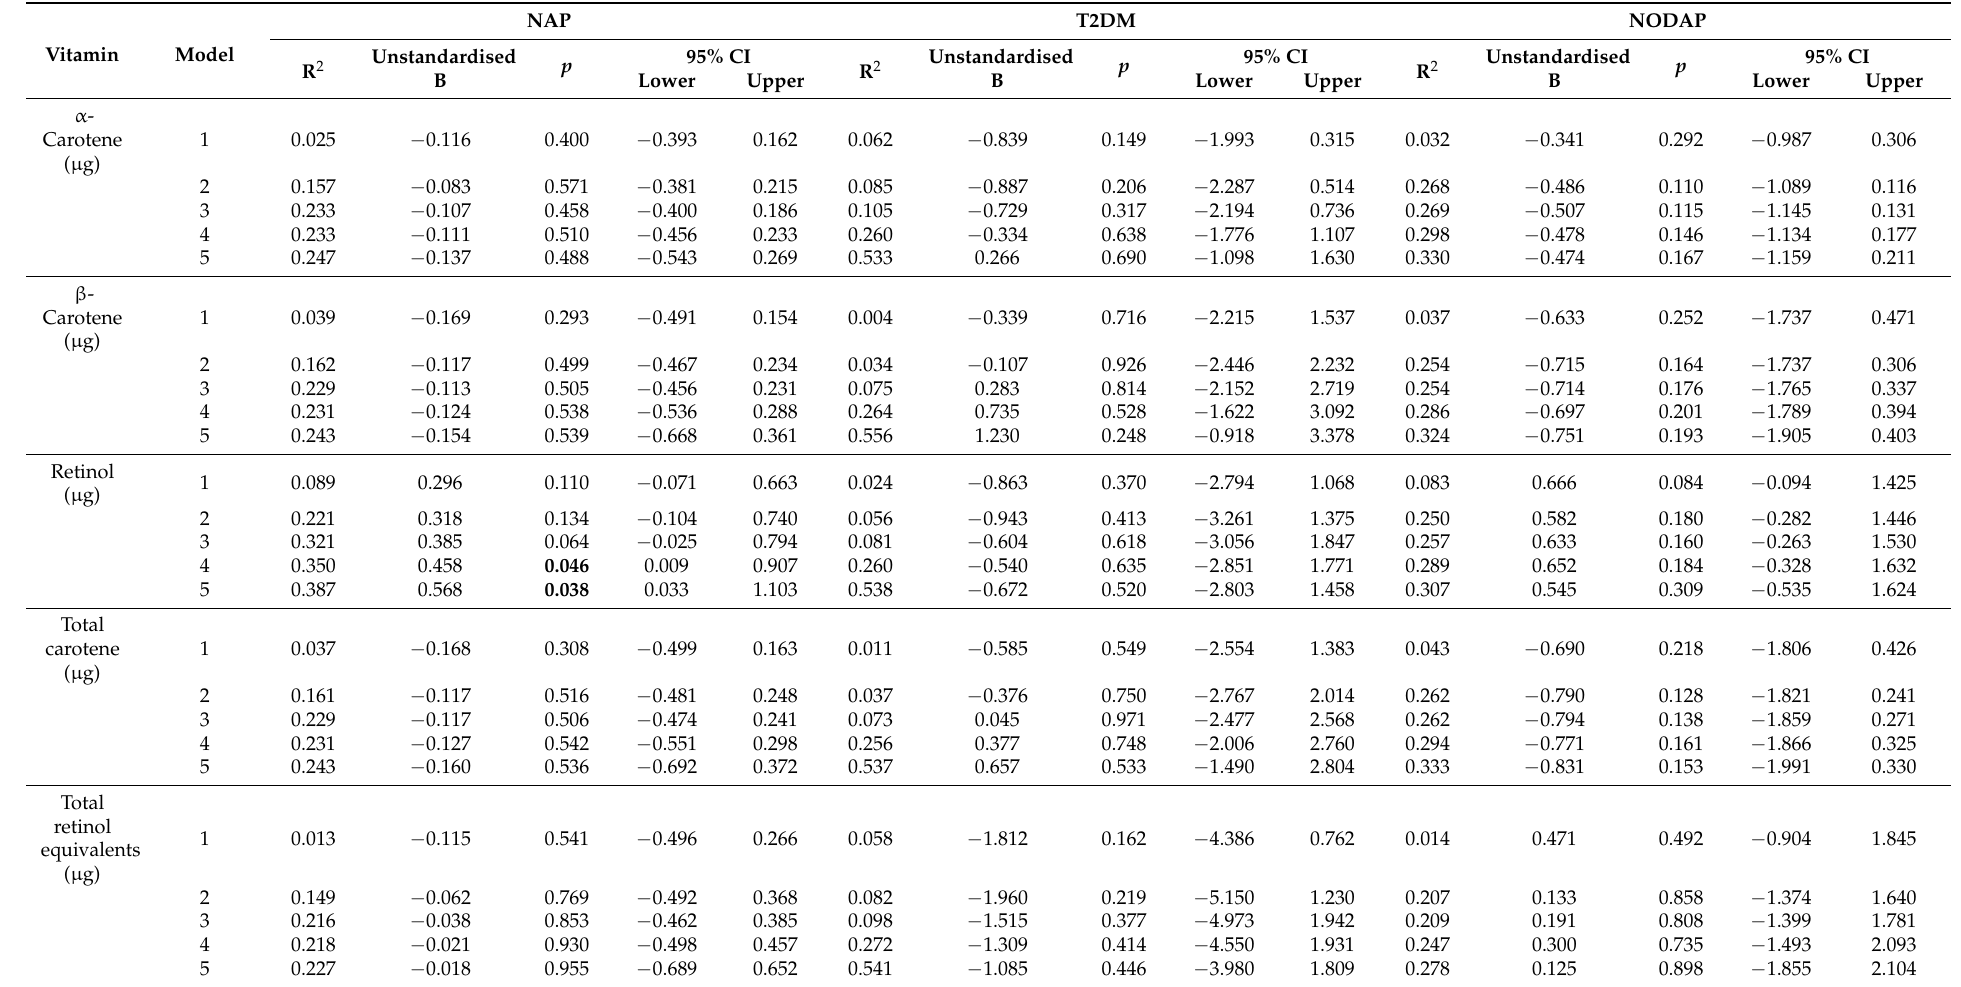
Table 2. Associations between habitual fat-soluble vitamin/vitamer intake and fasting plasma glucose in the study